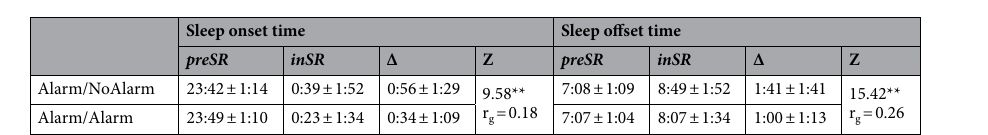
Figure 3. The contribution of alarm clock use on workdays to changes in daily behavior in participants who work from home inSR and used alarm clock preSR : Alarm/NoAlarm (green markers) and Alarm/Alarm (black markers) groups. Mean values of individual ( a ) SD week (h), ( b ) MSF sc (chronotype, local time), and ( c ) SJL (h) parameters preSR and inSR . Mean ∆ in minutes and Wilcoxon Matched-Pairs two-tailed tests Z statistic for each parameter are shown on the graphs, *p < 0.001.